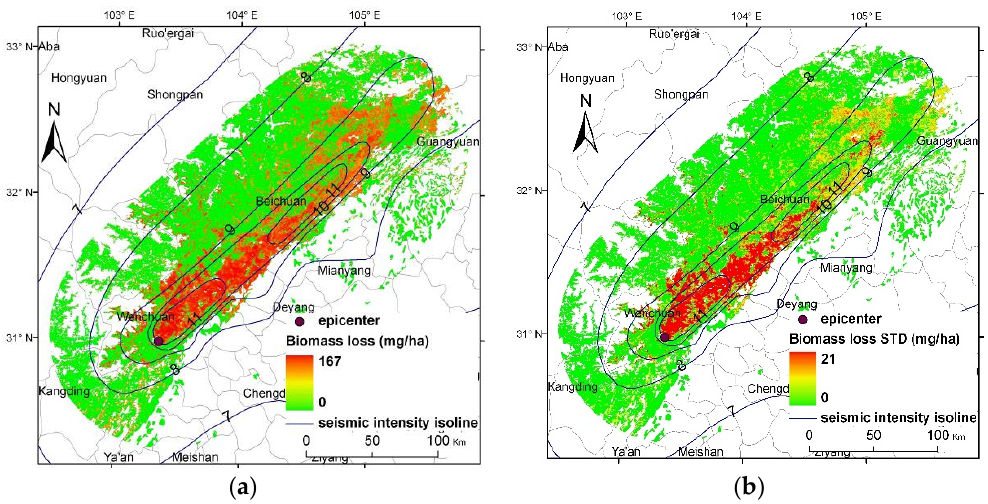
Figure 8. Mean value ( a ) and variance value ( b ) of forest biomass loss from the Wenchuan earthquake at the pixel scale.